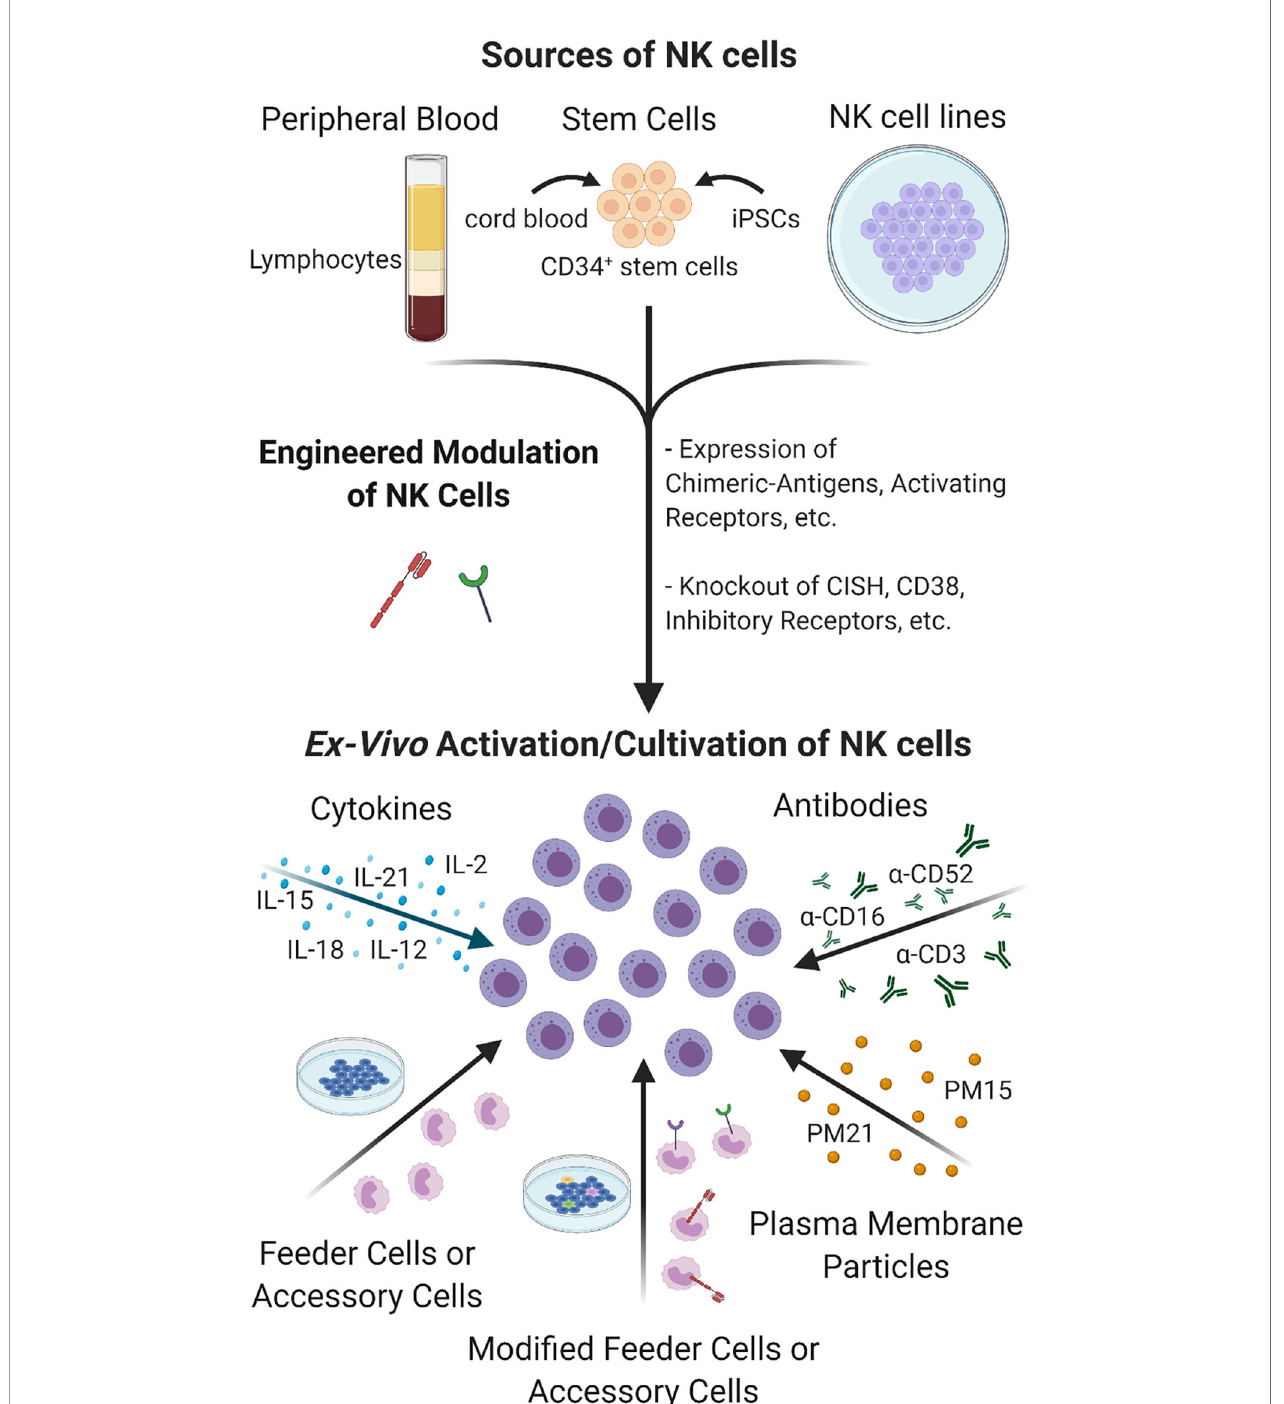
FIGURE 5 | Sources and Cultivation of NK cells. NK cells can be extracted from peripheral blood or be differentiated from CD34 + stem cells sourced from cord blood, placenta or manufactured from iPSCs. Tumor-derived NK cell lines are also being developed to expand large numbers of NK cells ex vivo . NK cells can be engineered to express cytokines, natural or modi fi ed receptors, or transformed to knock out inhibitory receptors and other molecules to enhance their cultivation, targeting and activity under TME. Unmodi fi ed or genetically engineered NK cells can be further activated and/or expanded by culturing in the presence of cytokines or antibodies alone or in combination with co-culturing with feeder cells or accessory cells, which themselves can be modi fi ed for greater activation. Feeder cell-free NK expansion methods have also been developed such as using plasma membrane particles that provide robust expansion of highly cytotoxic NK cells comparable to feeder cell- based methods without the drawbacks and safety